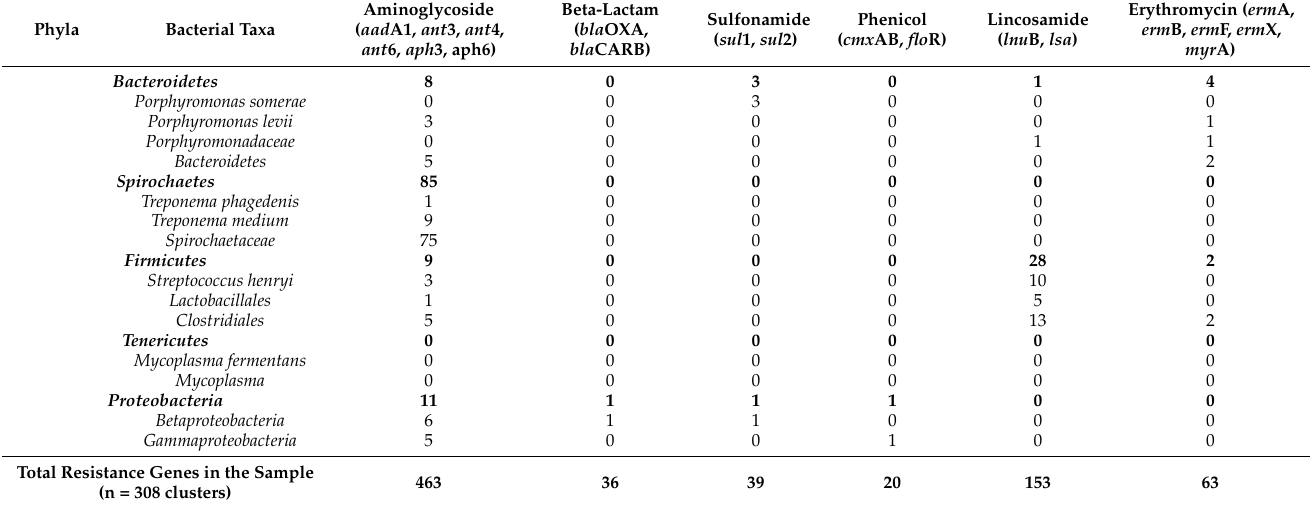
Table 4. Aminoglycoside, beta-lactam, sulfonamide, phenicol, lincosamide, and erythromycin resistance determinants hosted by microbiota of digital dermatitis lesions for 40 clusters with ≥ 80% complete genome; resistance genes are in